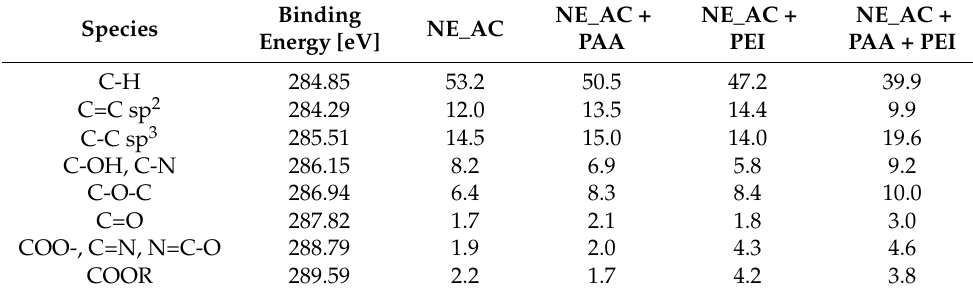
Table 6. The main C 1s photopeaks of the investigated samples